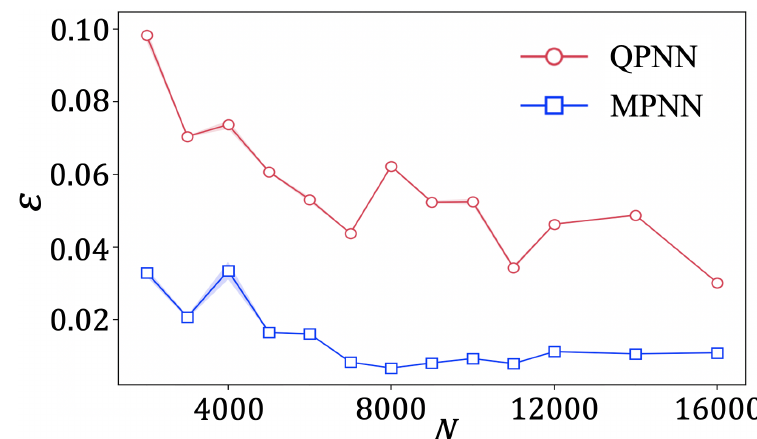
Figure 2: (Color online) The average of the error (cid:34) [ Eq. (10) ] by MPNN and QPNN with different numbers of samples N used to optimize NN. For each point in the curve, we implement 10 independent simulations to obtain the average and the variance that is O ( 10 − 3 ) or less (illustrated by the shadows). The numbers of hidden variables in the three layers of the NN are taken as 128, 128, and 128, respectively.